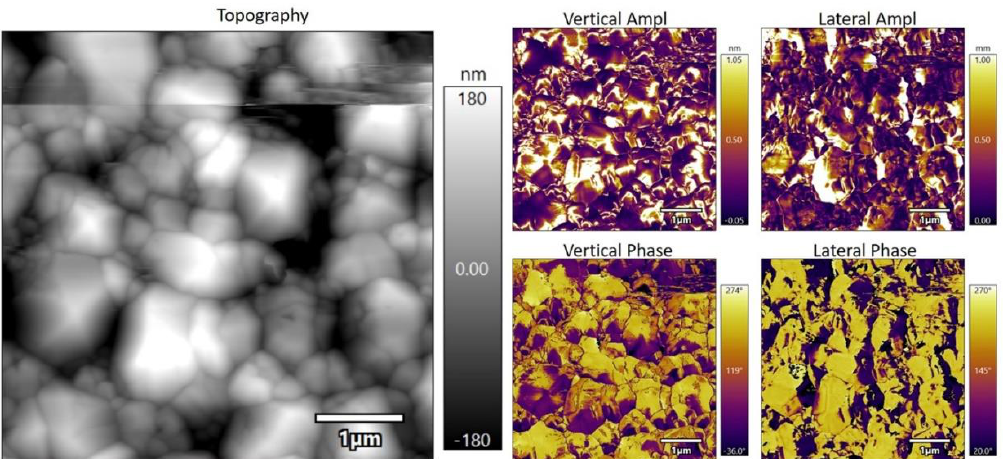
Figure 5. Topography and piezoresponse force microscopy (PFM) images of a BaTiO 3 film. The analysis was performed in a 5 × 5 µm 2 region on two BaTiO 3 -coated samples, and representative images were selected.